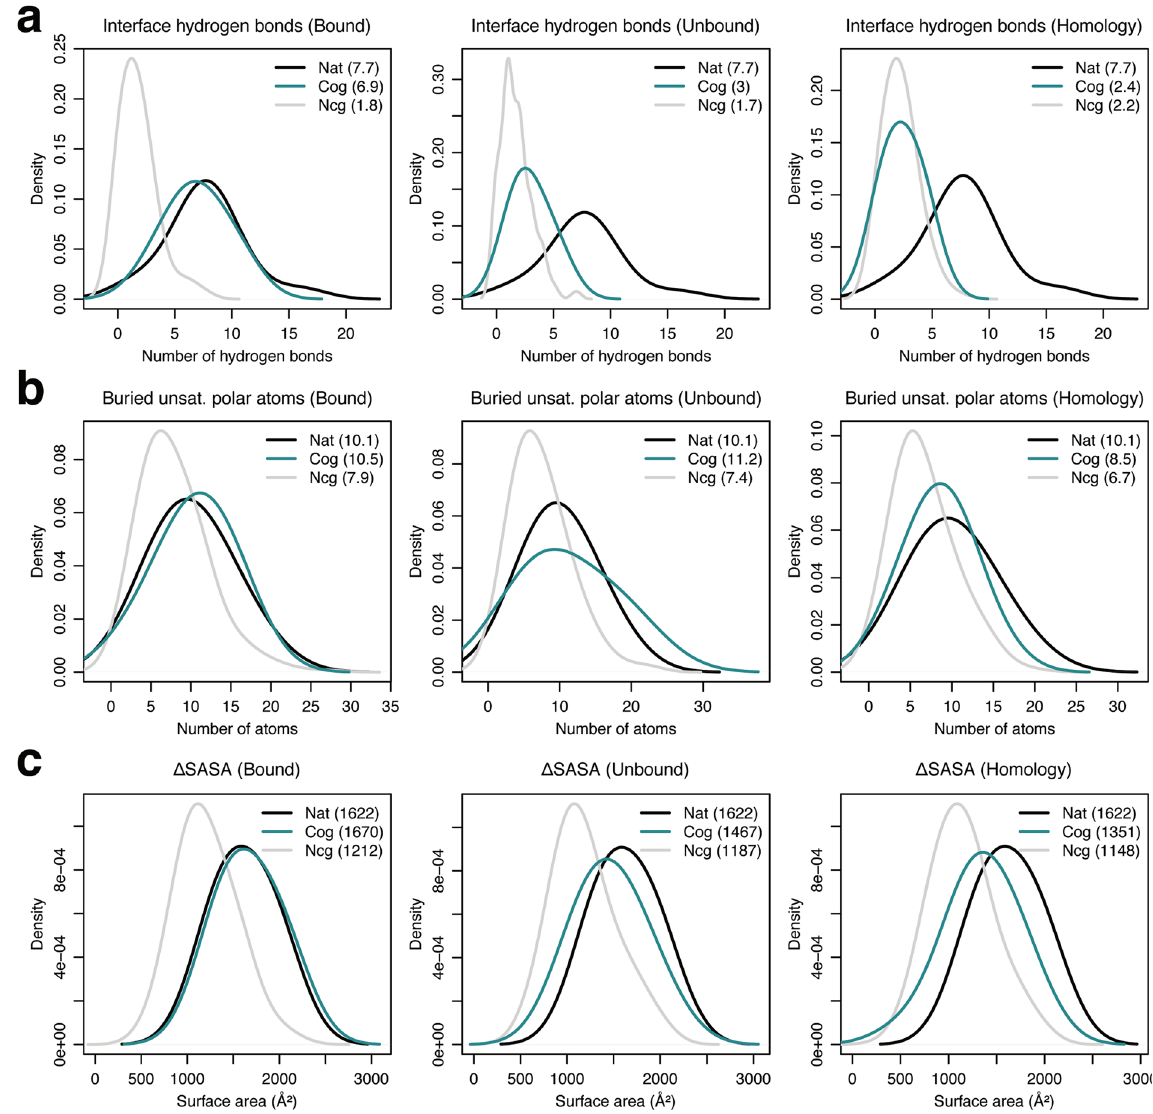
Figure 4. Interface metric distributions for local refine models. Kernel density estimate curves for the number of ( a ) interface hydrogen bonds, ( b ) buried unsatisfied interface polar atoms, and ( c ) surface area change upon binding ( Δ SASA) for the native crystal complexes (black), and the top-scoring cognate (turquoise) and non- cognate (grey) models generated using local refine for bound, unbound, and homology antibody–antigen